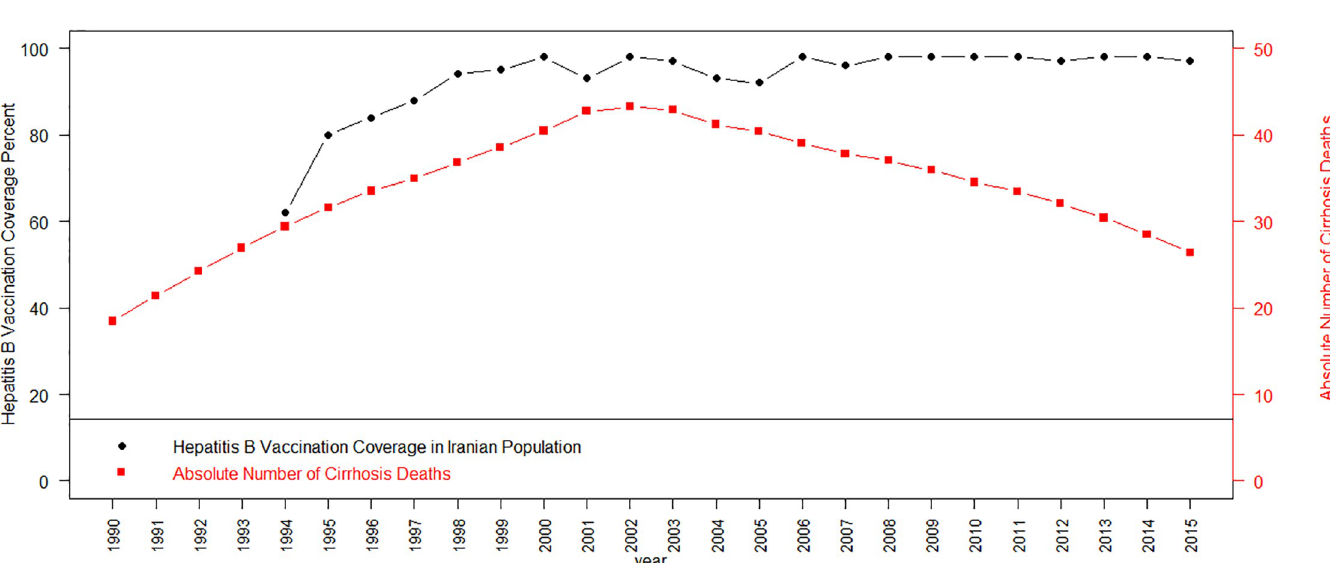
PLOS ONE | https://doi.org/10.1371/journal.pone.0198449 January 15,